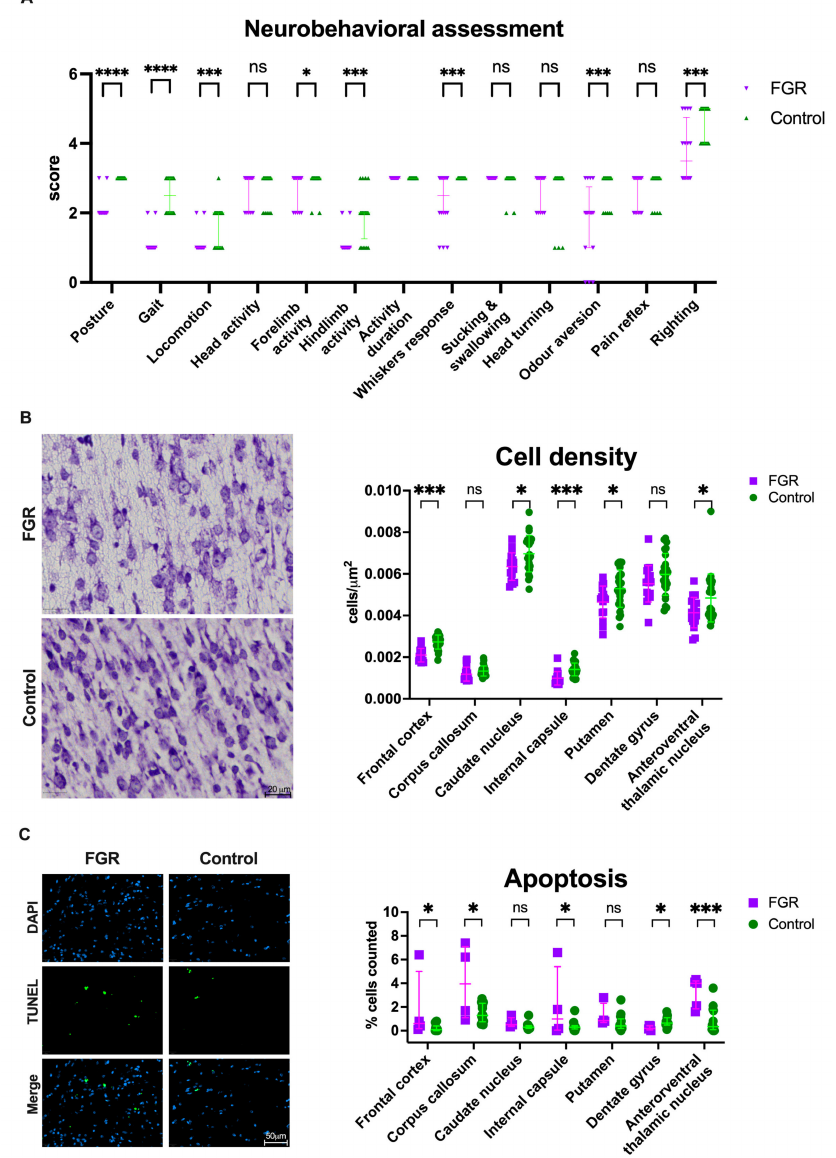
Figure 3. Neuropathology in postnatal day 1 rabbit brains: ( A ) Neurobehavioral tests grouped scores from 18 FGR and 25 control subjects from 7 litters. ( B ) Cell density was assessed in cresyl violet